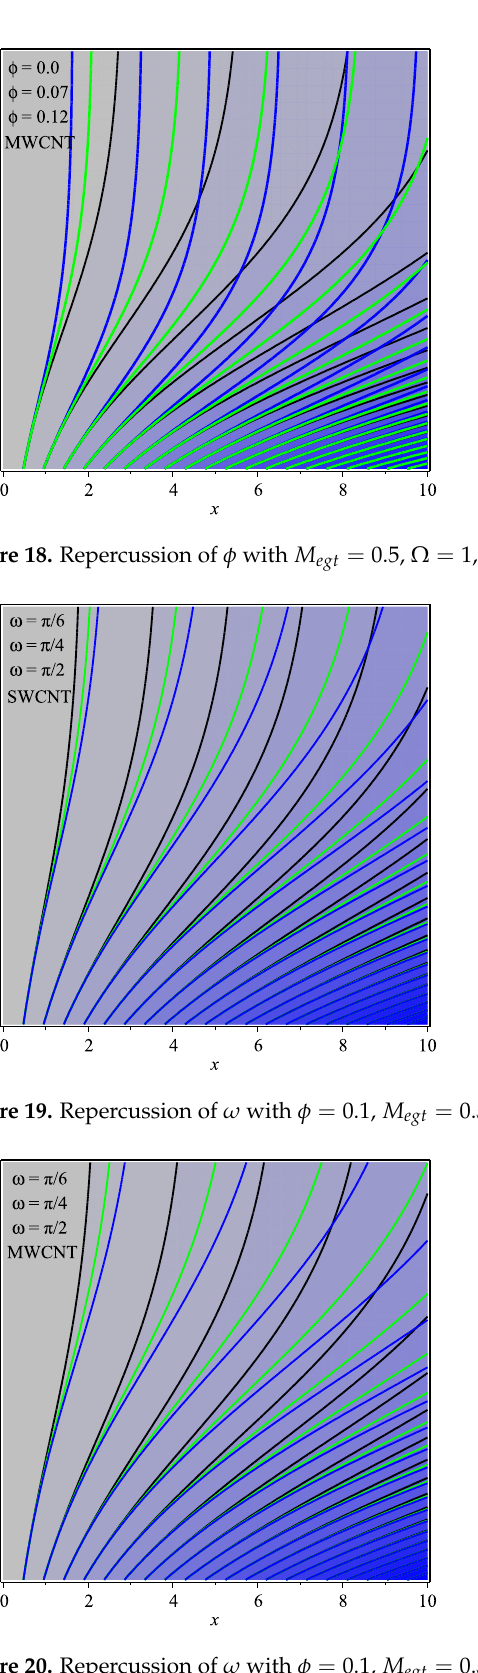
Figure 20. Repercussion of ω with φ = 0.1, M egt = 0.5, Ω = 1, κ = 2.5 on stream